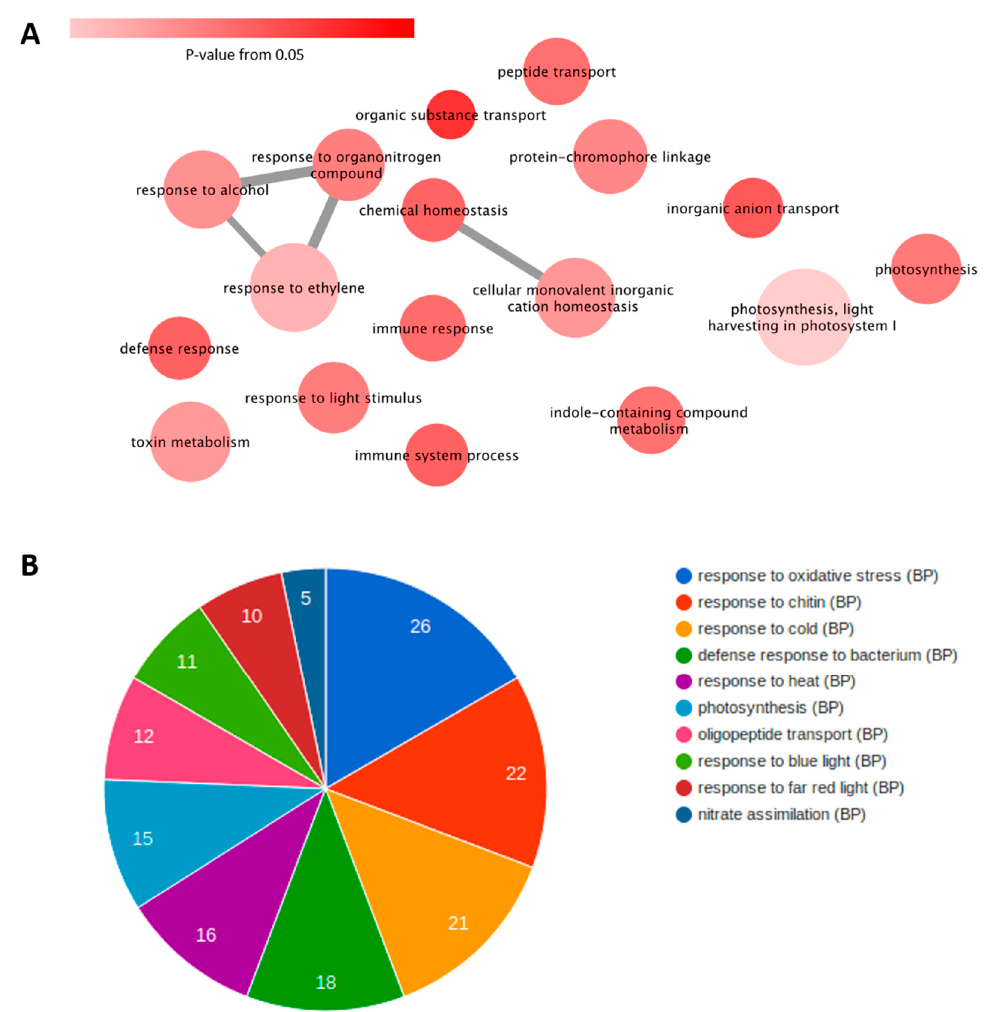
Figure 3. Biological processes (BPs) and their functional annotation in antagonism (PapMV → PRSV). ( A ) Network of non-redundant unique BPs in antagonism. Edges represent relationships between the BPs (nodes). Node color intensity denotes the p -value of the sample. Size of the node represents the number of DEGs. ( B ) Number of DEGs for each BP, per concurrent annotations, through a modular enrichment analysis for PapMV → PRSV.